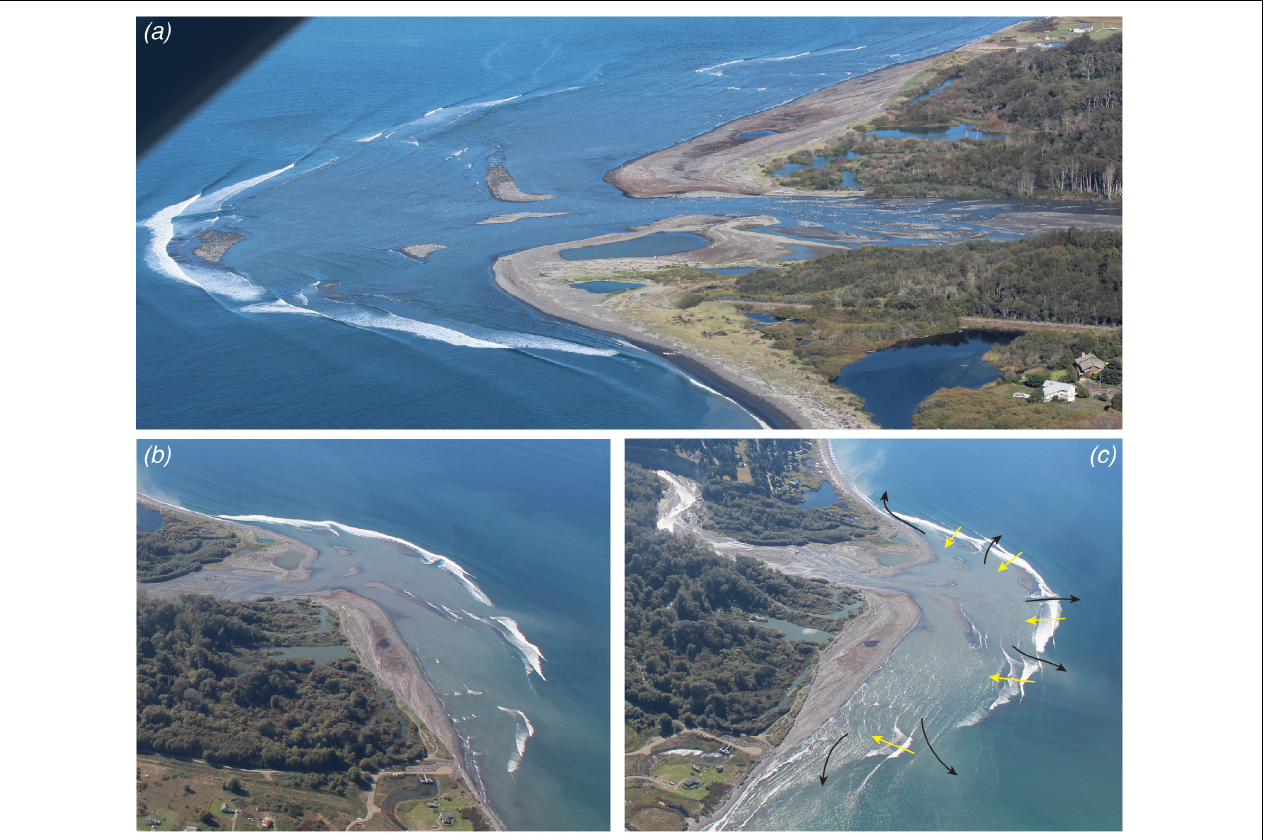
FIGURE 9 | (a–c) Oblique aerial photographs of the Elwha River mouth from September 27, 2013 highlighting wave-breaking patterns on river mouth bars that are related to cross-shore and longshore sediment transport. Hypothesized flow pathways are highlighted in the lower right panel showing onshore flow across bars (yellow arrows) and offshore return flow through channels in the gaps between bars (black arrows). Photo credits: Neal and Linda Chism of